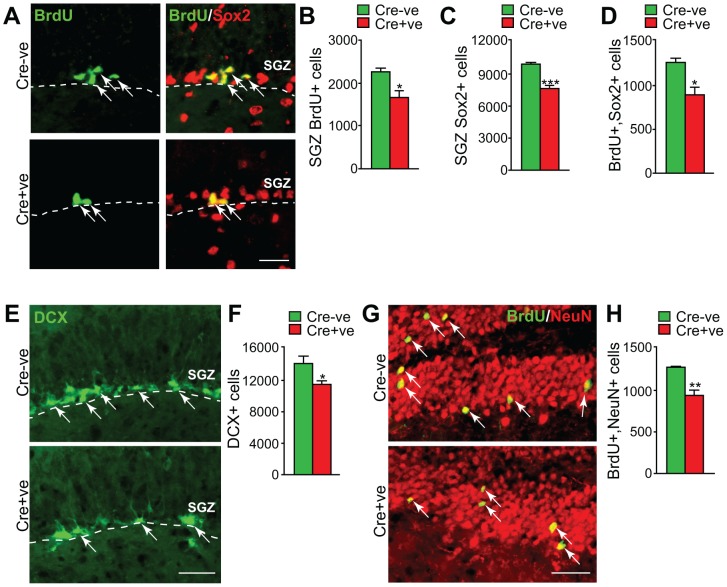
Genetic ablation of Snail perturbs the proliferation of adult dentate gyrus neural precursor cells and the number of adult-born hippocampal neurons.(A–D) Adult Snailfl/fl mice that were positive (Cre+ve) or negative (Cre-ve) for the nestin-cre transgene were injected with BrdU and coronal sections through the hippocampal dentate gyrus were analyzed one day later. (A) Fluorescence micrographs of sections through the dentate gyrus subgranular zone (SGZ) immunostained for BrdU (green) and Sox2 (red; right panels show the merged images). Arrows denote double labeled cells and the hatched white line the border of the SGZ and the hilus. Scale bar 50 µm. (B–D) Quantification of sections as in A for the total relative numbers of BrdU-positive cells (B), Sox2-positive cells (C) and BrdU-positive, Sox2-positive double-labelled cells (D) in the SGZ as determined by counting all positive cells in 10 sections spanning the dentate gyrus. (*p<0.05, ***p<0.001, n = 4 each). (E–H) One month old Snailfl/fl mice that were positive (Cre+ve) or negative (Cre-ve) for the nestin-cre transgene were injected multiple times with BrdU over the course of one day and the hippocampus was analyzed one month later. (E) Fluorescence micrographs of coronal sections through the dentate gyrus immunostained for doublecortin (DCX, green). Arrows denote doublecortin-positive cells and white hatched lines the border of the SGZ. Scale bar 50 µm. (F) Quantification of sections as in E for the total relative number of doublecortin-positive cells as determined by counting all positive cells in 10 sections spanning the dentate gyrus. (*p<0.05, n = 4 each). (G) Fluorescence micrographs of coronal sections through the dentate gyrus immunostained for BrdU (green) and NeuN (red). Arrows denote double-labelled cells. Scale bar 50 µm (H) Quantification of sections as in G for the total relative number of double labeled BrdU-positive, NeuN-positive cells, as determined by counting all positive cells in 10 sections spanning the dentate gyrus. (**p<0.01, n = 4 each).